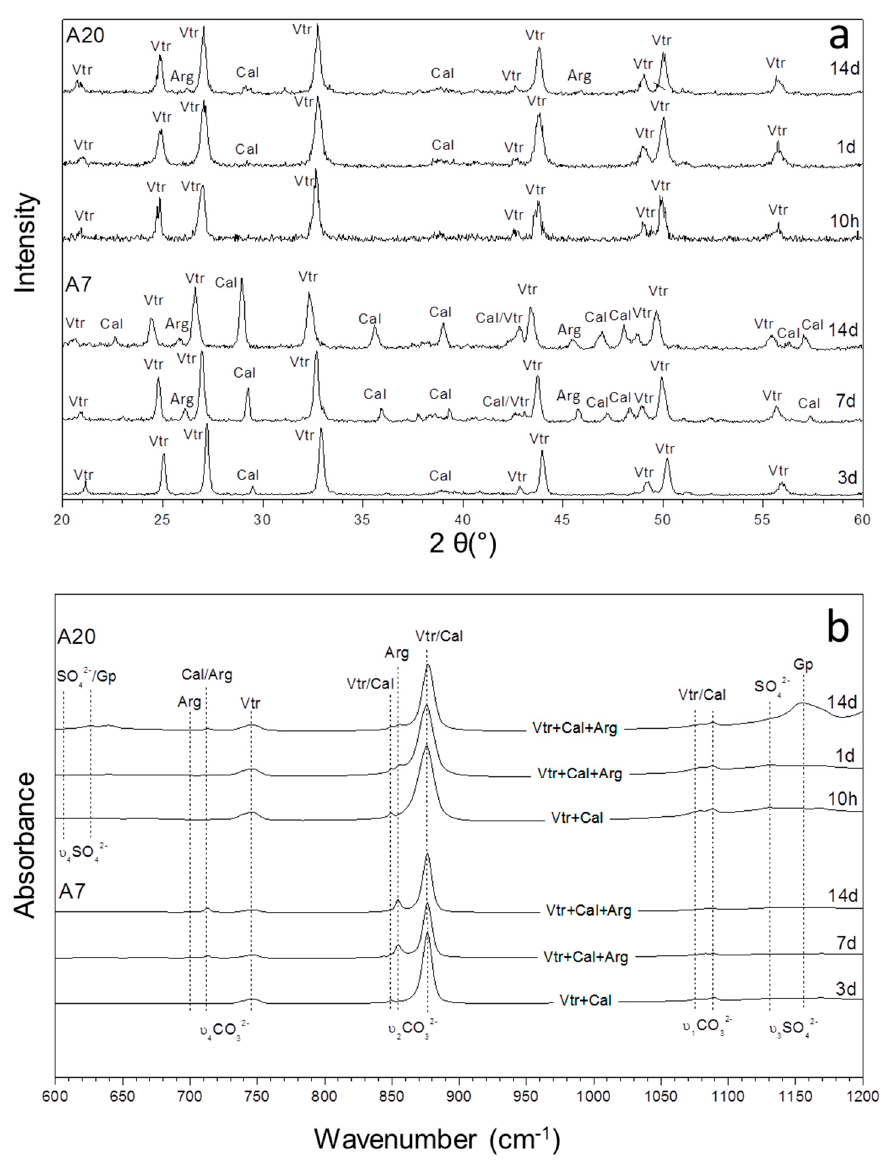
Figure 3. The XRD patterns ( a ) and infrared spectra ( b ) of precipitates sampled from aqueous solutions with (SO 42 − )/(CO 32 − ) ratios of 19.51 and 54.87 (A7 and A20) as a function of time.